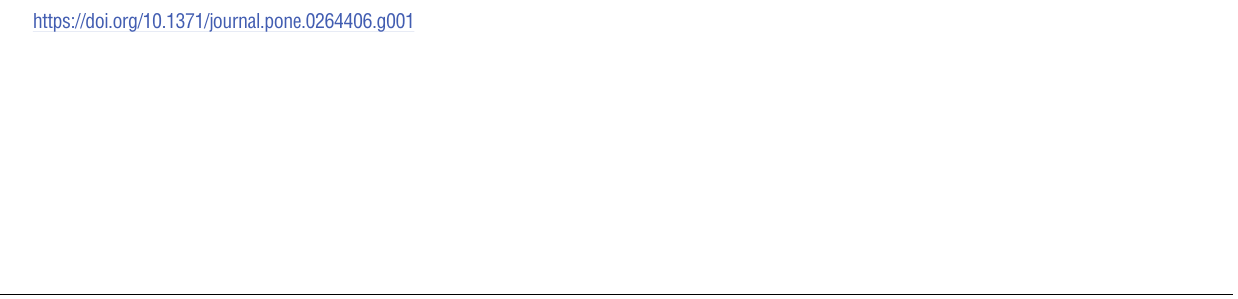
Fig 1. Geological settings and fossil site. A) Iberian Peninsula remarking the Southwestern Iberian Ranges where Las Hoyas locality (red star) is located. (B) Geological map of Serranı´a de Cuenca, depicting the Las Hoyas Basin. (C) Excavated squares and photography of the Theropod trackway and microbial impressions on the Magenta